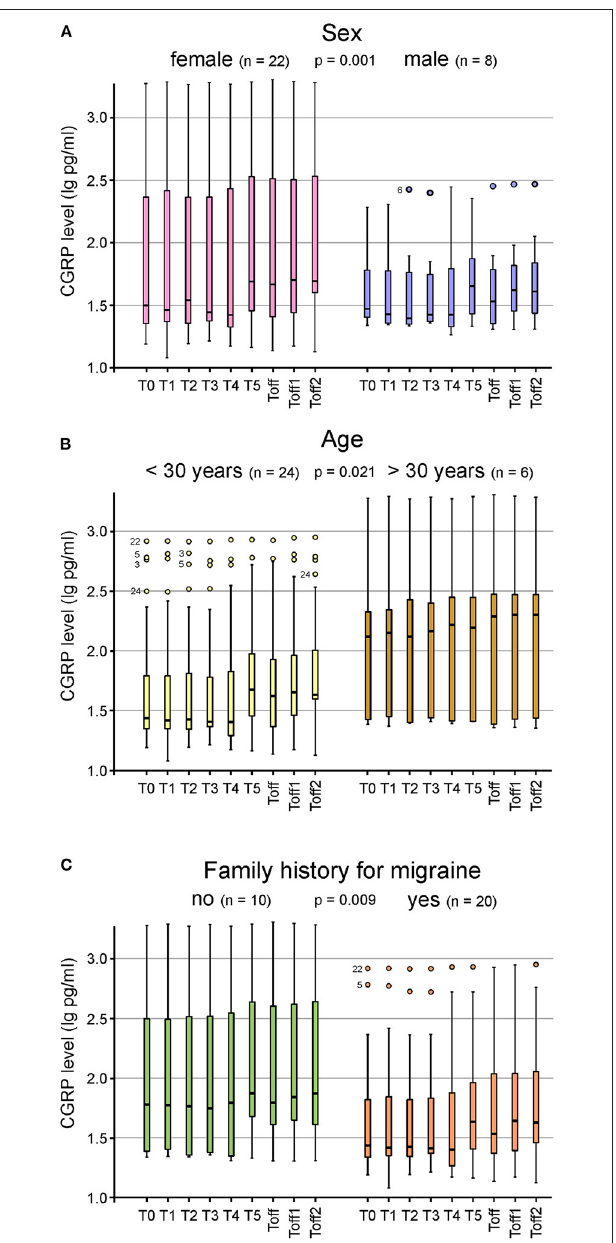
FIGURE 3 | Box plots for the CGRP plasma levels at the different timepoints shown for sex (A) , age (B) and family history for migraine (C) . Significantly higher CGRP levels were found in female subjects ( n = 22; p = 0.001) (A) , in participants older than 30 years ( n = 24; p = 0.021) (B) and in those with a negative family history ( n = 10; p = 0.009) (C) . Mild outliers are marked with a circle (O), the number next to it represents the corresponding